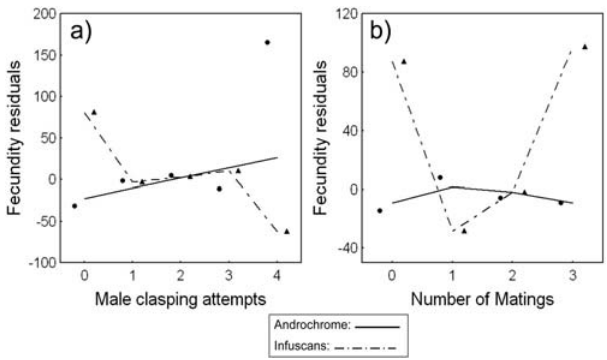
Figure 4. Fitness functions (cubic splines) showing morph-specific relationships between fecundity and minimum recorded number of mating attempts and realized matings. The fecundity-effects of population and year were removed prior to this analysis (fecundity- residuals are shown on Y-axis). Androchrome females (n=200, solid lines and circles) and Infuscans-females (n=78, broken lines and triangles), differ both with respect to a) Male clasping attempts (Morph * No. claspings: x 2 =7.657, d.f.=1, P=0.006) and with respect to b) Number of matings (Morph * No. matings: x 2 =4.755, d.f.=1, P=0.029). Interaction tests were estimated in generalized linear models (GLZ; with Poisson error, see methods). Because there were only 5 individuals across all morphs that had mated four times, these were excluded from the final model, however, results remained significant with their inclusion. Data-points show mean fecundity values for each particular morph and mating category.